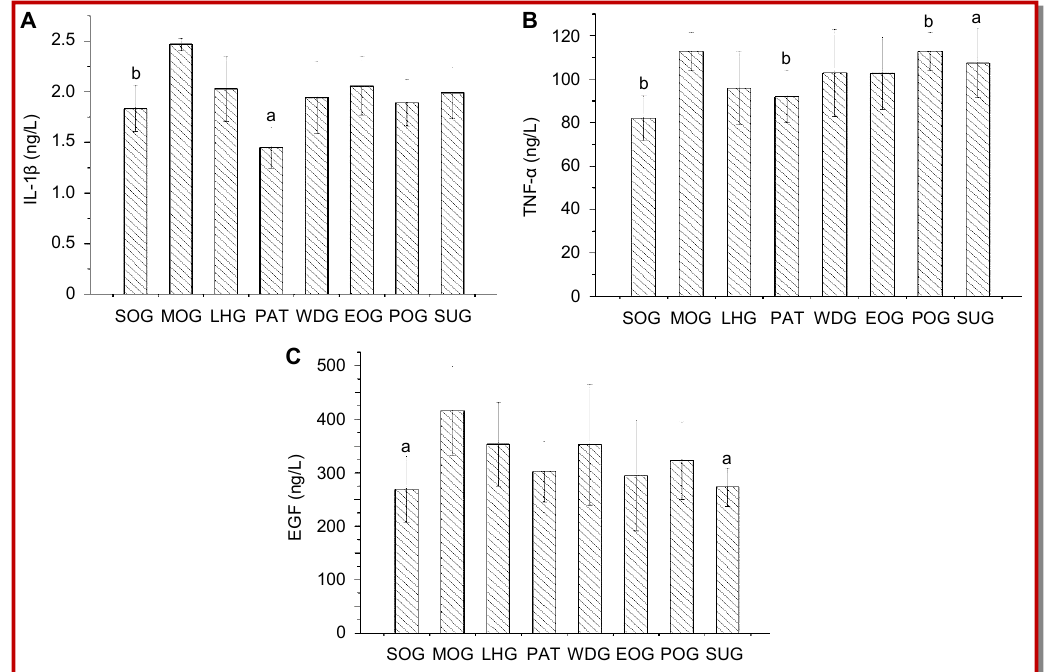
Figure 4: Effect of different constituents of T. patula on prostate IL-1 (cid:451), TNF- (cid:450) and EGF levels . Values are in mean ± SD; n = 8; a = p<0.05, b = p<0.01 Vs the model group